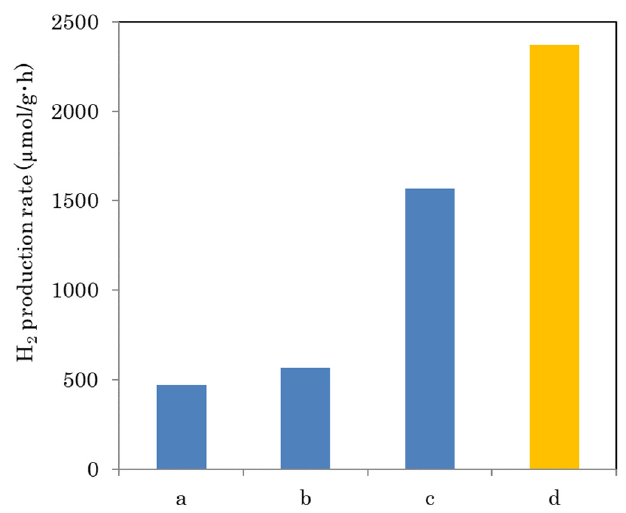
Figure 6. Photocatalytic hydrogen production rate with ( a ) ZnIn 2 S 4 , ( b ) Zn 0.87 In 2 S 3.87 , ( c ) Zn 0.87 Cu 0.13 In 2 S 3.935 and ( d ) Zn 0.74 Cu 0.13 In 2 S 3.805 .